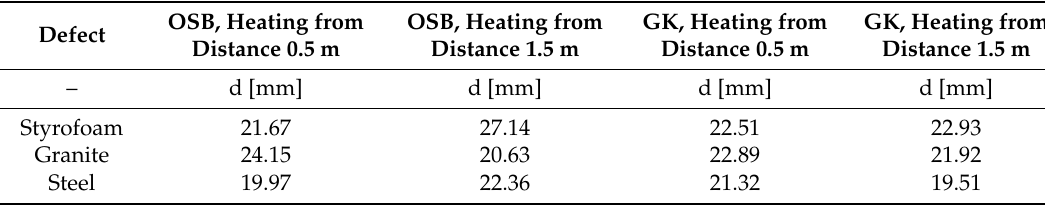
Table 2. Defect location depths calculated using the EDS Table 1. Defect location depths calculated using the EDS method.